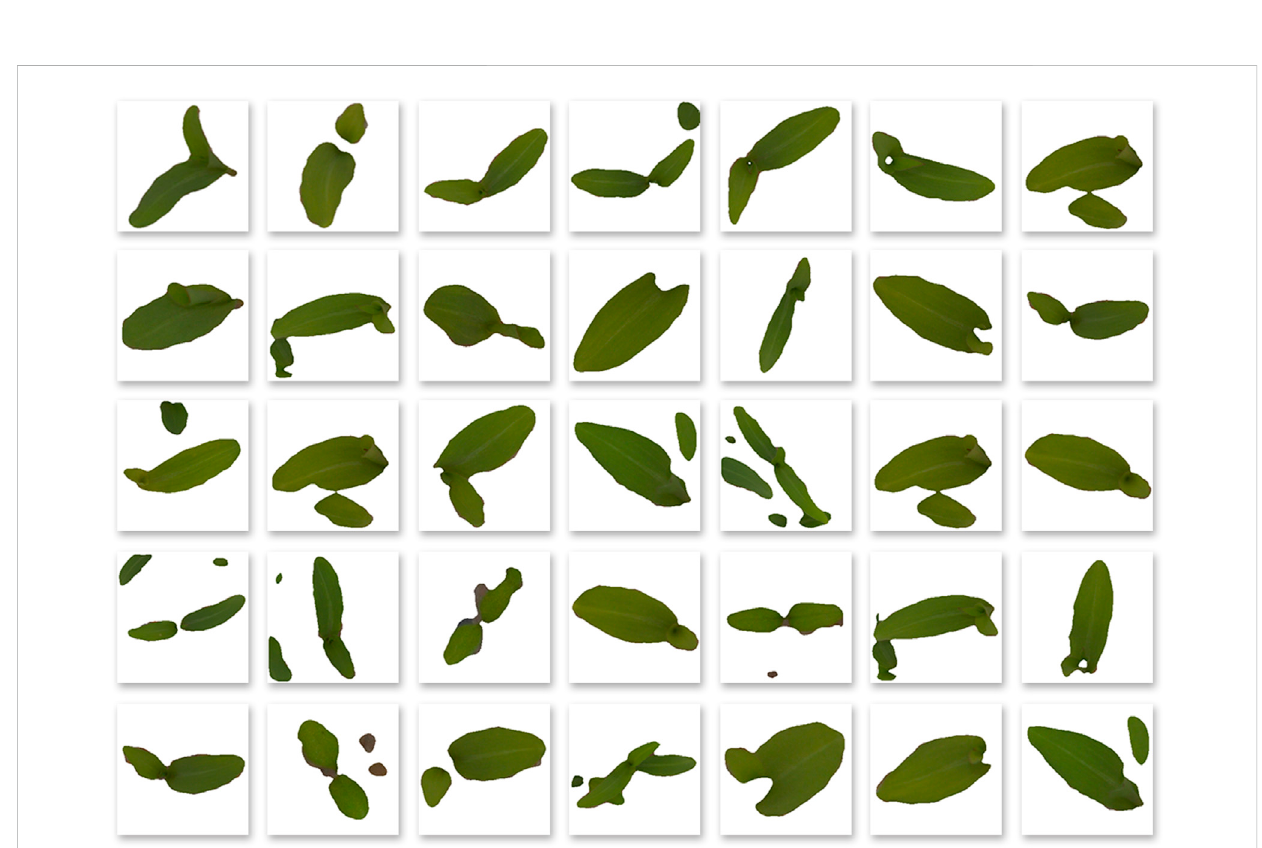
FIGURE 6 Part of the data set samples is segmented by the proposed